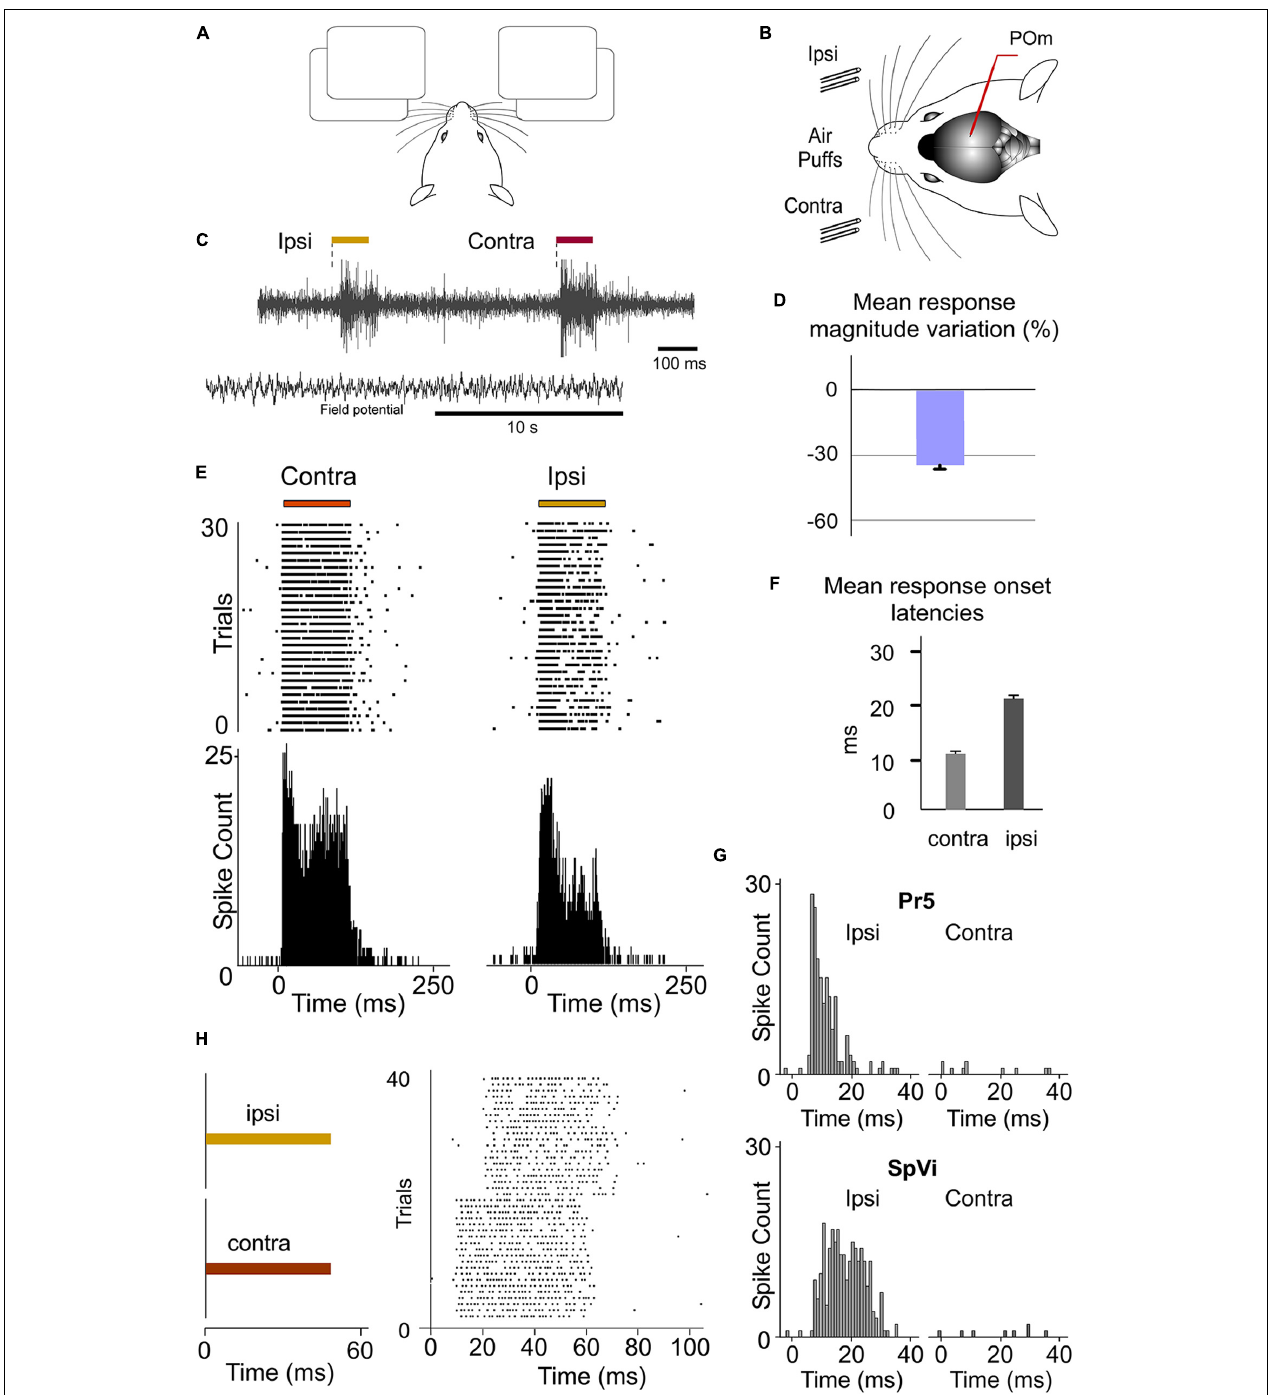
FIGURE 8 | POm responses to tactile stimulation of ipsilateral whiskers. (A) Simulated illustration representing the use of bilateral information. (B) Schematic drawing displaying the sensory stimulation via patterns of contra-, ipsi-, or bilateral multiwhisker deflections. Recordings were made in POm. (C) Evoked activity produced by ipsi- and contralateral stimuli from the same recording in POm during the lightly anesthetized state. Field potential activity recorded in this state is also shown. (D) Mean ipsilateral response magnitude was significantly less than contralateral one ( p < 0.001, Wilcoxon matched-pairs test, n = 90 multi-units). (E) Raster plots and PSTHs showing sustained POm responses evoked by contra- and ipsilateral multiwhisker stimulation. (F) Mean onset latencies of contra- and ipsilateral responses ( n = 90 multi-units). The onset latency of ipsilateral responses ranged from 18 to 35 ms. (G) Evoked responses to contralateral whisker stimulation were not found in the Pr5 and SpVi trigeminal nuclei. Sustained responses to ipsilateral stimulation were only found in SpVi. (H) POm responses also lasted the duration of the ipsilateral stimulus.